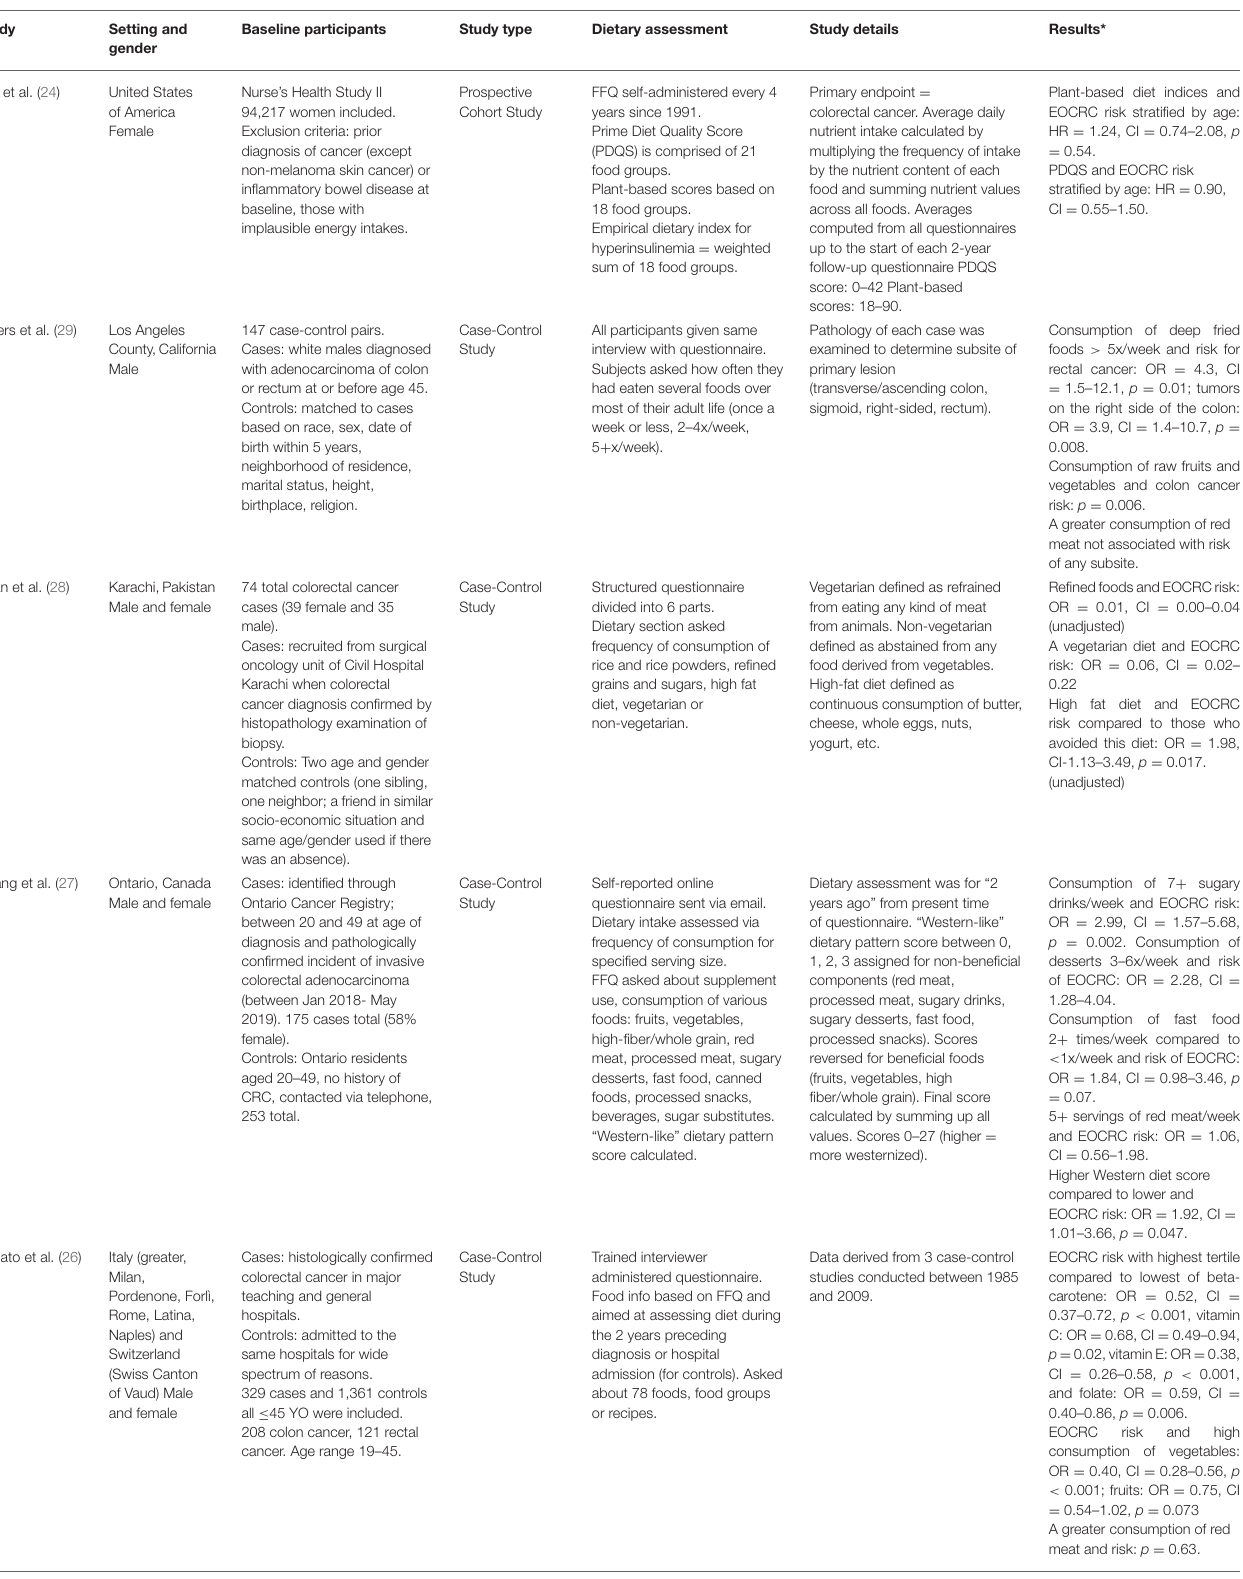
TABLE 3 | Characteristics of included studies (early-onset colorectal